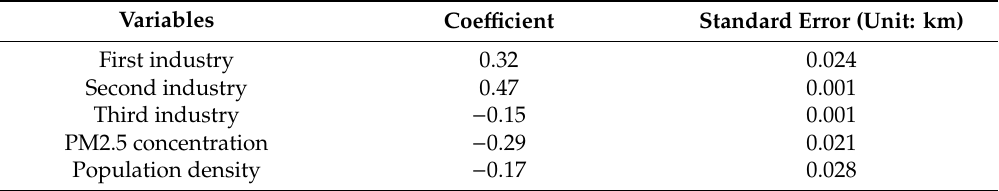
Table 1. Key parameters derived from the GWR models with combination explanatory